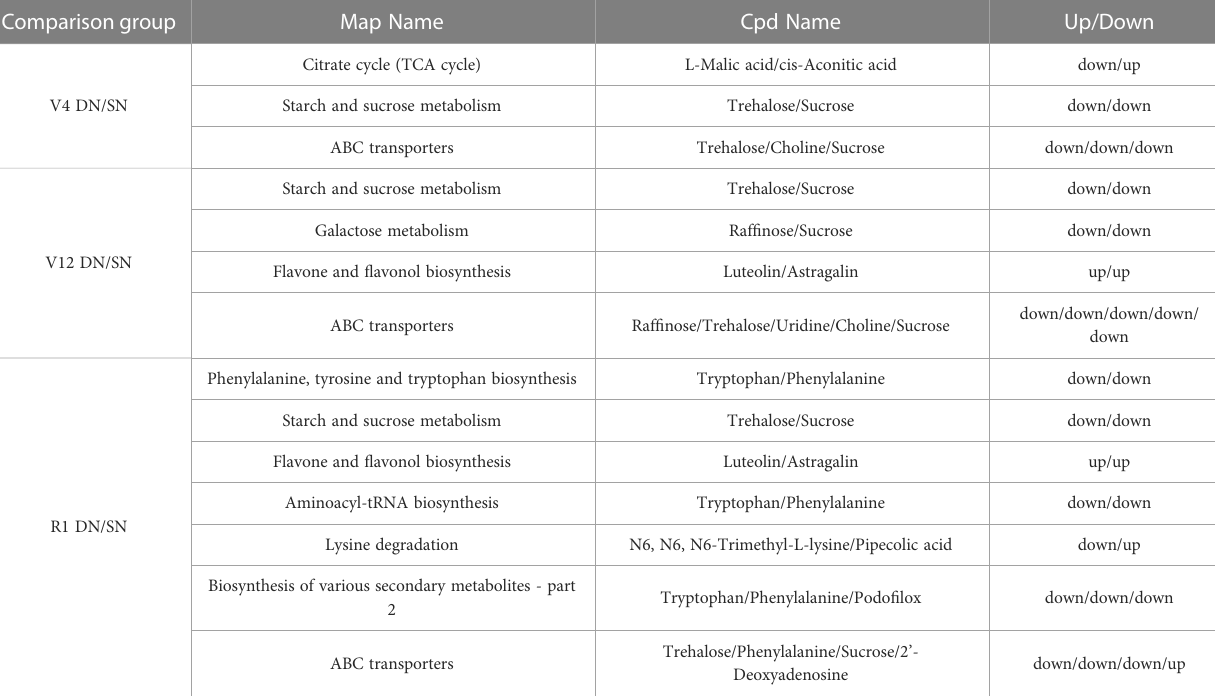
TABLE 2 Differential metabolites in KEGG metabolic